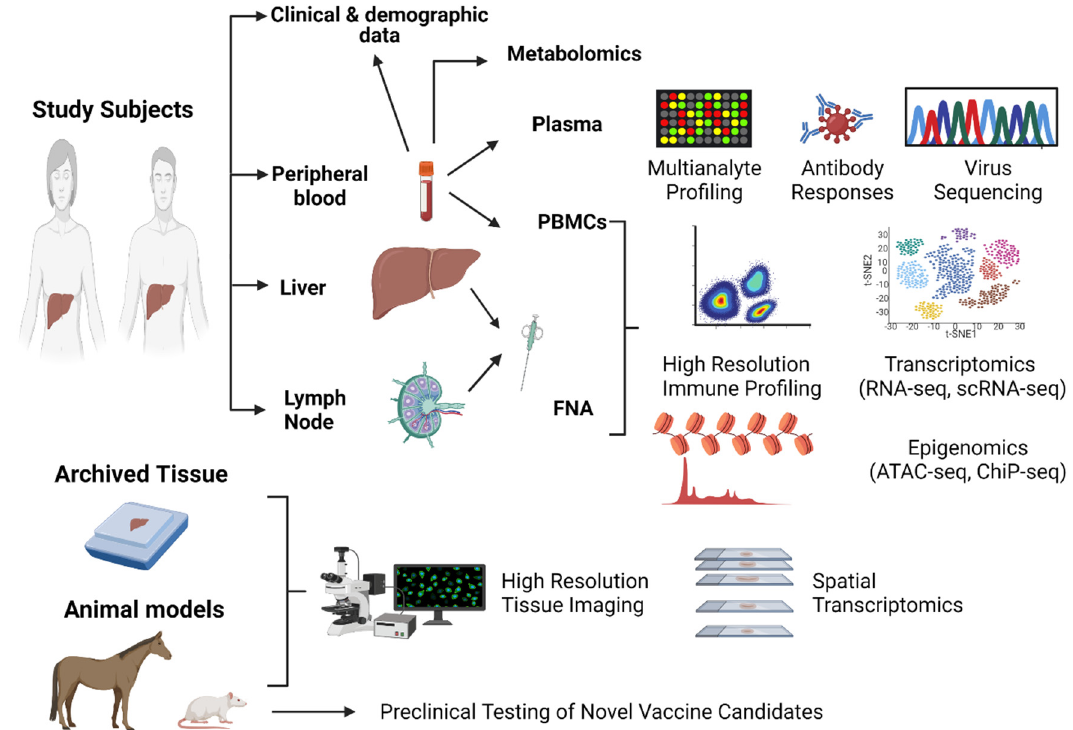
Figure 2. Proposed integrative strategy for a systems immunology approach to future HCV immunological studies and vaccine clinical trials. Blood samples, liver and lymph node fine-needle aspirates (FNA), archived liver tissue samples and animal models can be used in an integrative approach to identify correlates of protective immunity and inform vaccine development. Created with BioRender.com.